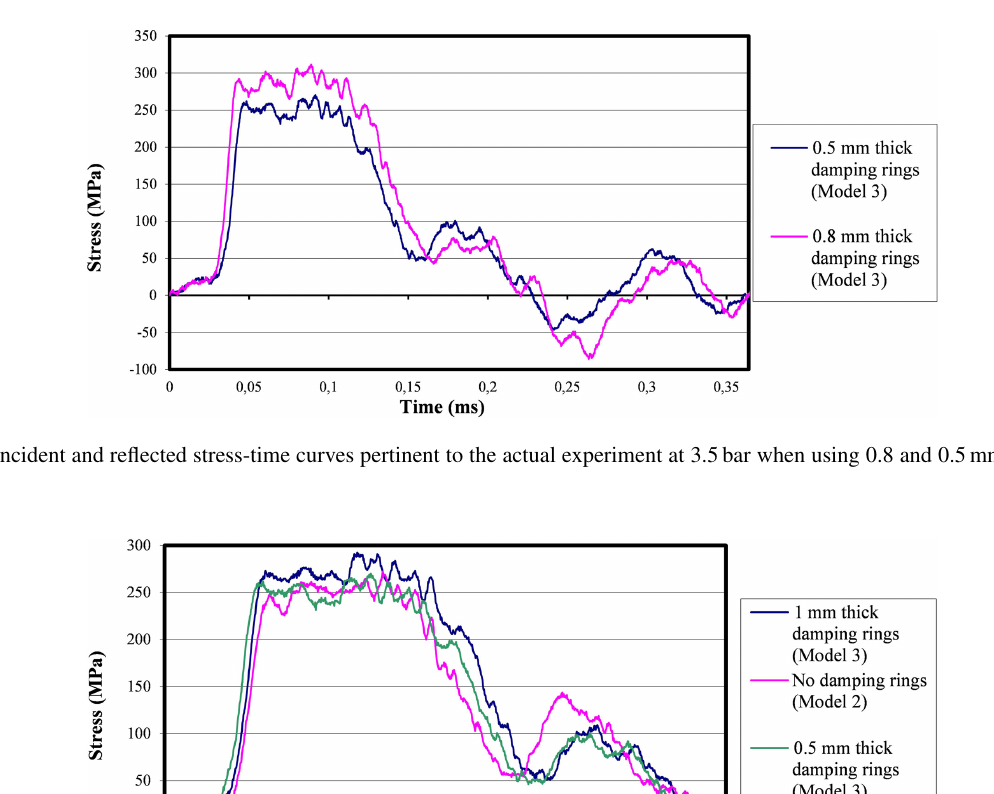
Figure 29. Stress-time curves pertinent to the actual experiment at 3.5bar when using 1mm thick and no damping rings.